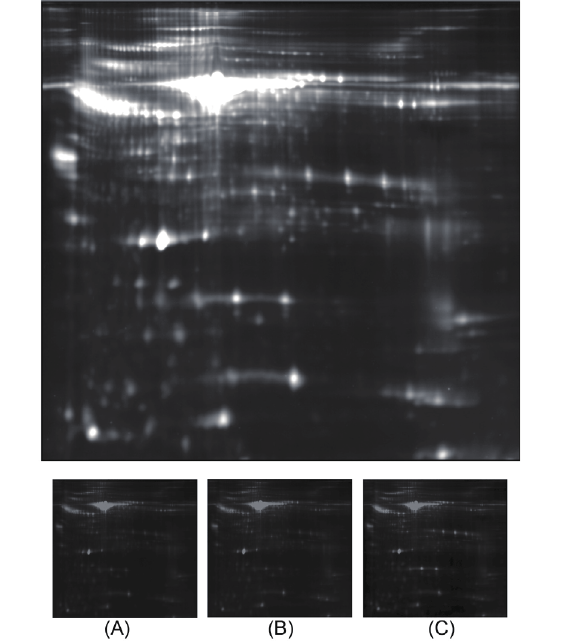
Figure 2. Two-dimensional differential gel electrophoresis (2D-DIGE) fluorescence image of one pair of CH and C samples with interior labels. (A) pooled interior label with Cy2. (B) MF labeled with Cy3. (C) C labeled with Cy5. The three pictures below: Individual channels of Cy2, Cy3, and